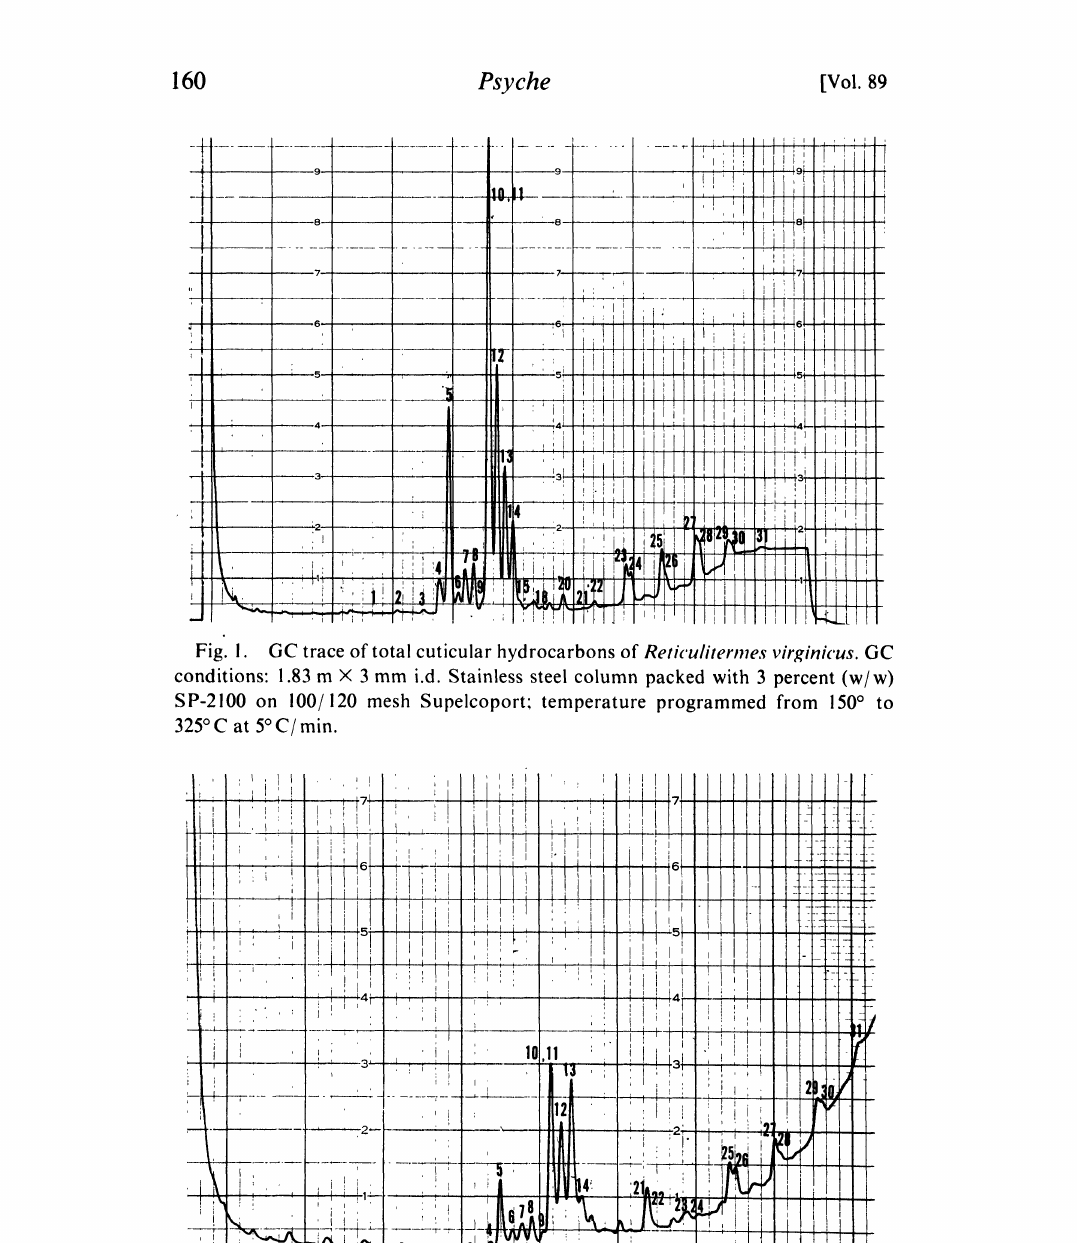
Fig. 2. GC trace of total cuticular hydrocarbons of Philotermes howardi. GC conditions same as for Fig.